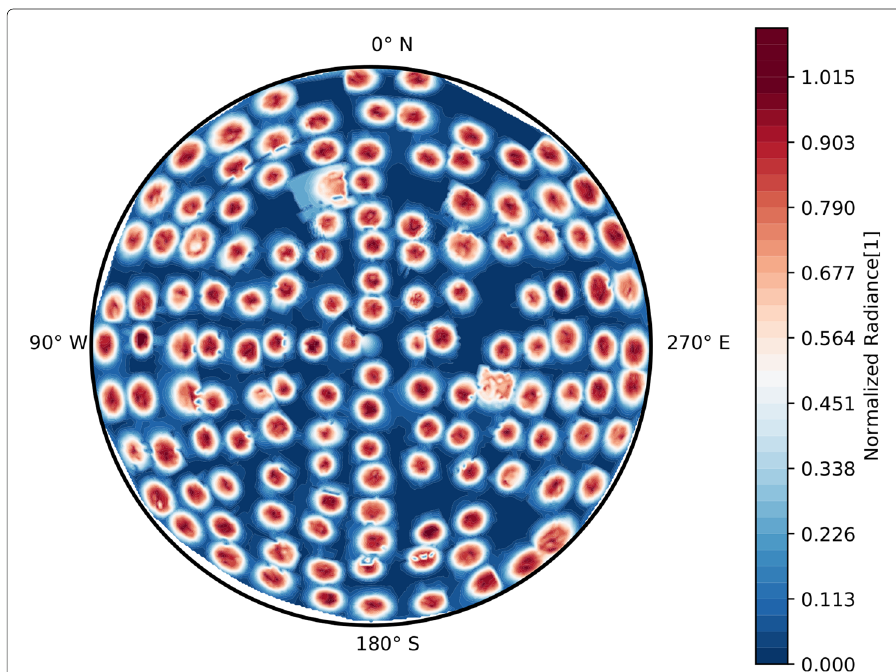
Fig. 15 Angular response of the AMUDIS input optics at 644 nm. Figure obtained from 20.949 uniformly distributed measurements over a virtual sphere of radius 102.5 cm and centred on the AMUDIS entrance